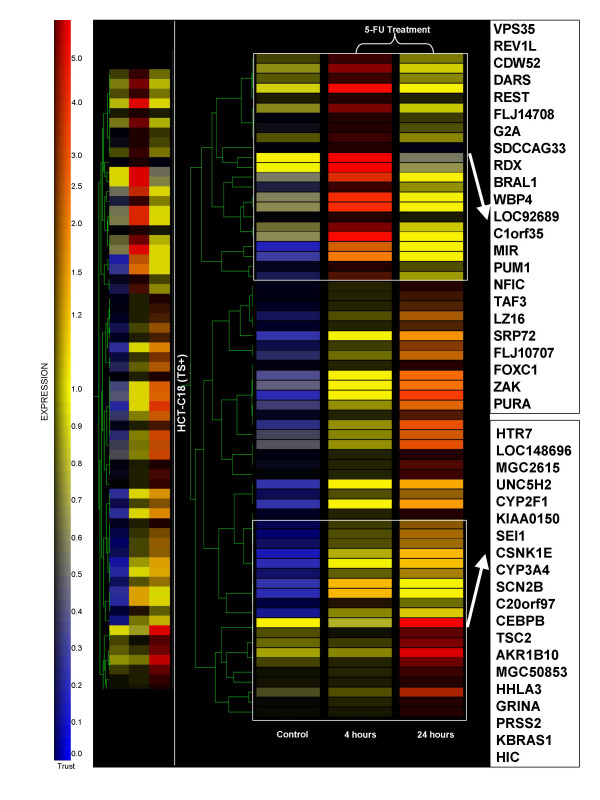
Clustering analysis of TS dependent cytotoxicity in HCT-C18 (TS+) cells (Lane 1) treated with 10 μM 5-FU for 4 hrs (Lane 2) and 24 hrs (Lane 3) based on the expression profiles generated from polysome associated mRNAs via One-way ANOVA analysis with p < 0.05.